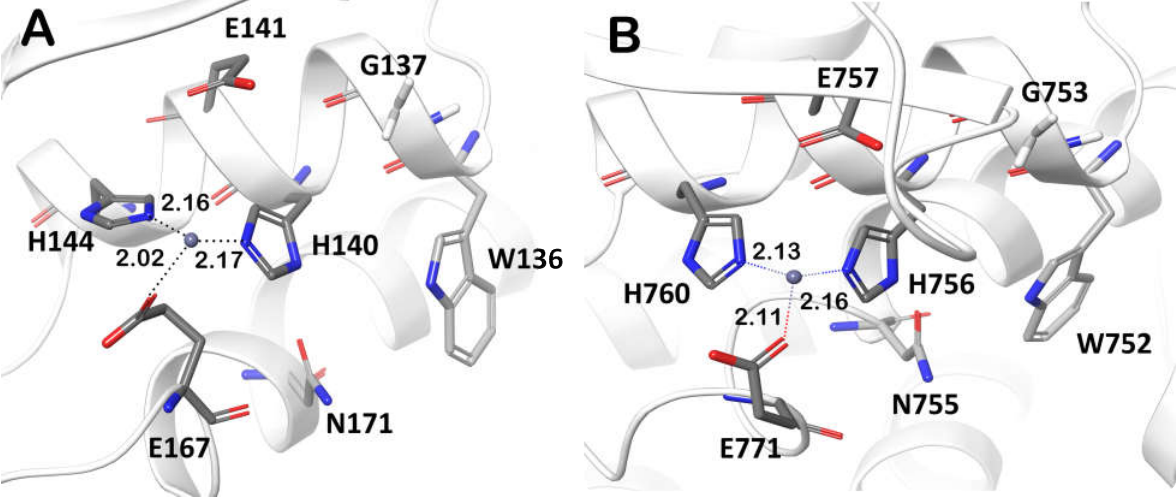
Figure 7. The conserved residues forming the zinc-binding motif HEXXHX(8,28)E and the carbohydrate binding site (W, G, N) in the active sites of the peptidase domains of the Svx protein of Pectobacterium atrosepticum ( A ) and the O-glycopeptidase ZmpB of Clostridium perfringens (pdb code: 5KDS) ( B ).